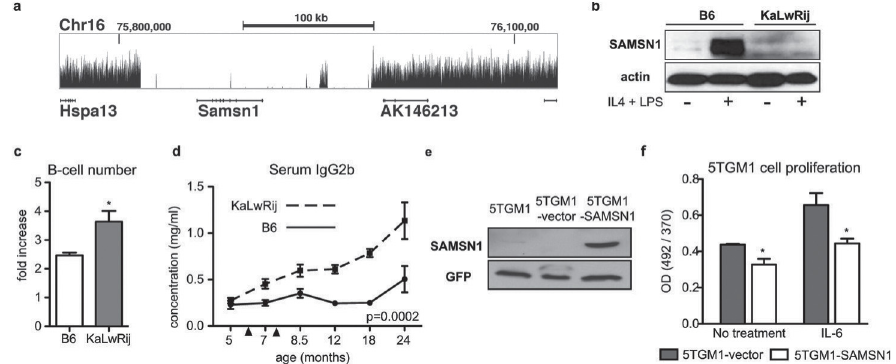
Fig 2. Samsn1 is deleted in KaLwRij and was a negative regulator in B-cells and transformed myeloma cells. (a) Genome sequence coverage is shown for the Samsn1 locus. Physical distance shown along the x-axis and the size and location of the region are indicated. Height of the curve represents accumulated sequencing reads. There are virtually no reads across Samsn1 indicating a total deletion of this gene. Hspa13 gene 5 ’ of Samsn1 (shown and labeled) is not affected, and neither are 3 ’ genes AK146213 (shown and labeled) or 4930578N18Rik (first two exons shown but not labeled). Samsn1